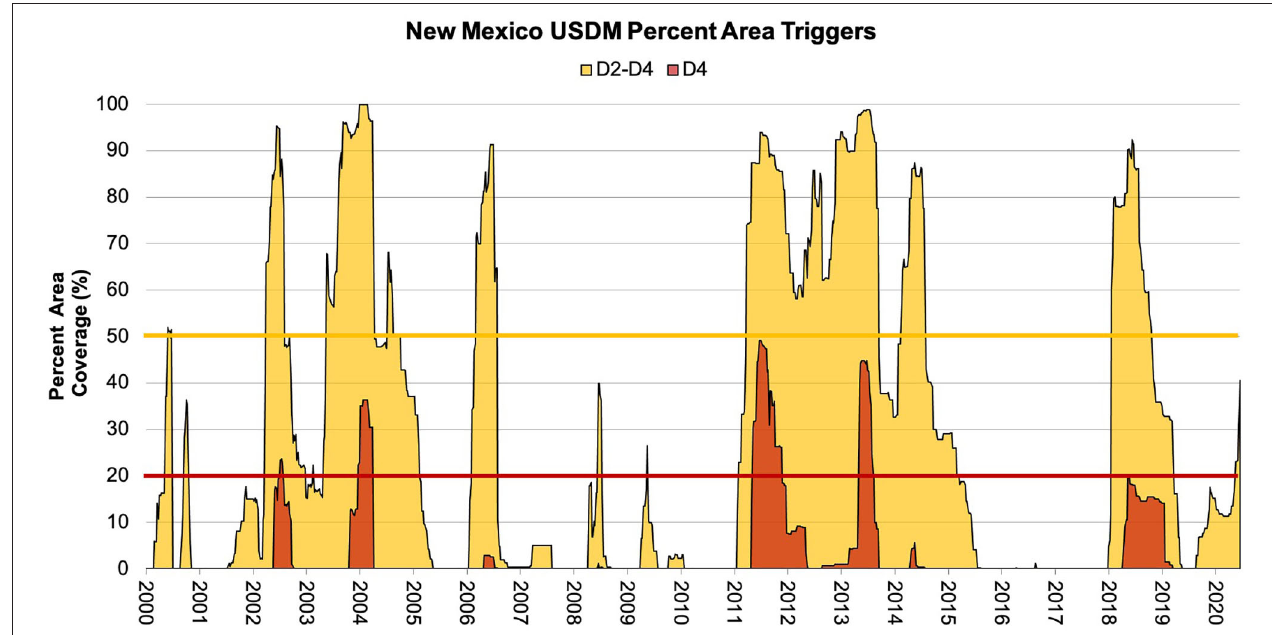
FIGURE 9 | State of New Mexico USDM D2-D4 and D4 categories with the 2018 NMDP equivalent triggers. The yellow line represents the Emergency trigger of 50% area of D2 conditions. The orange line represents the Exceptional trigger of 20% area of D4 conditions.